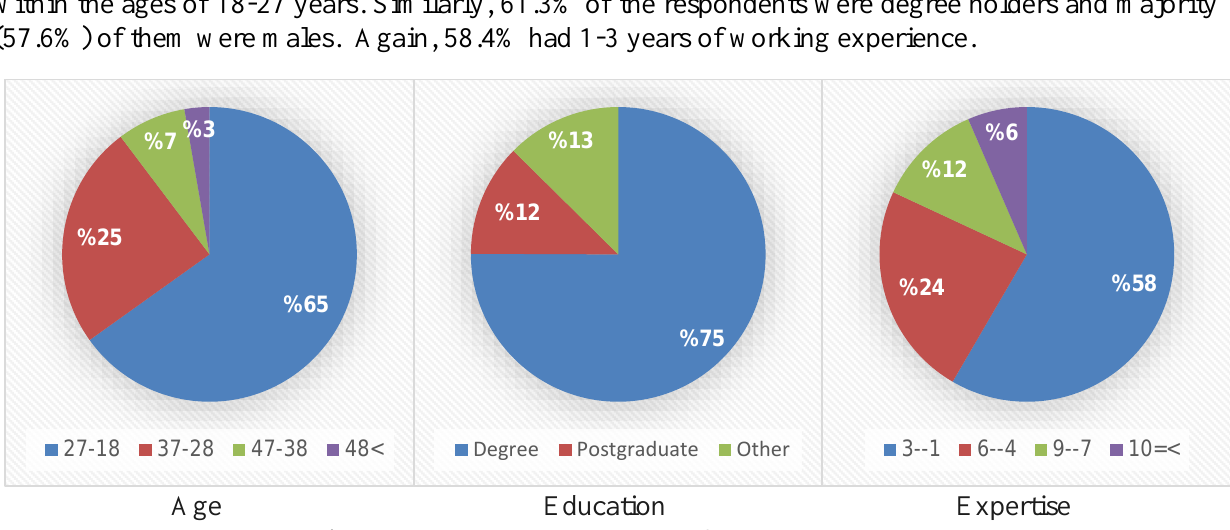
Fig. 1. Personal characteristics of the participants